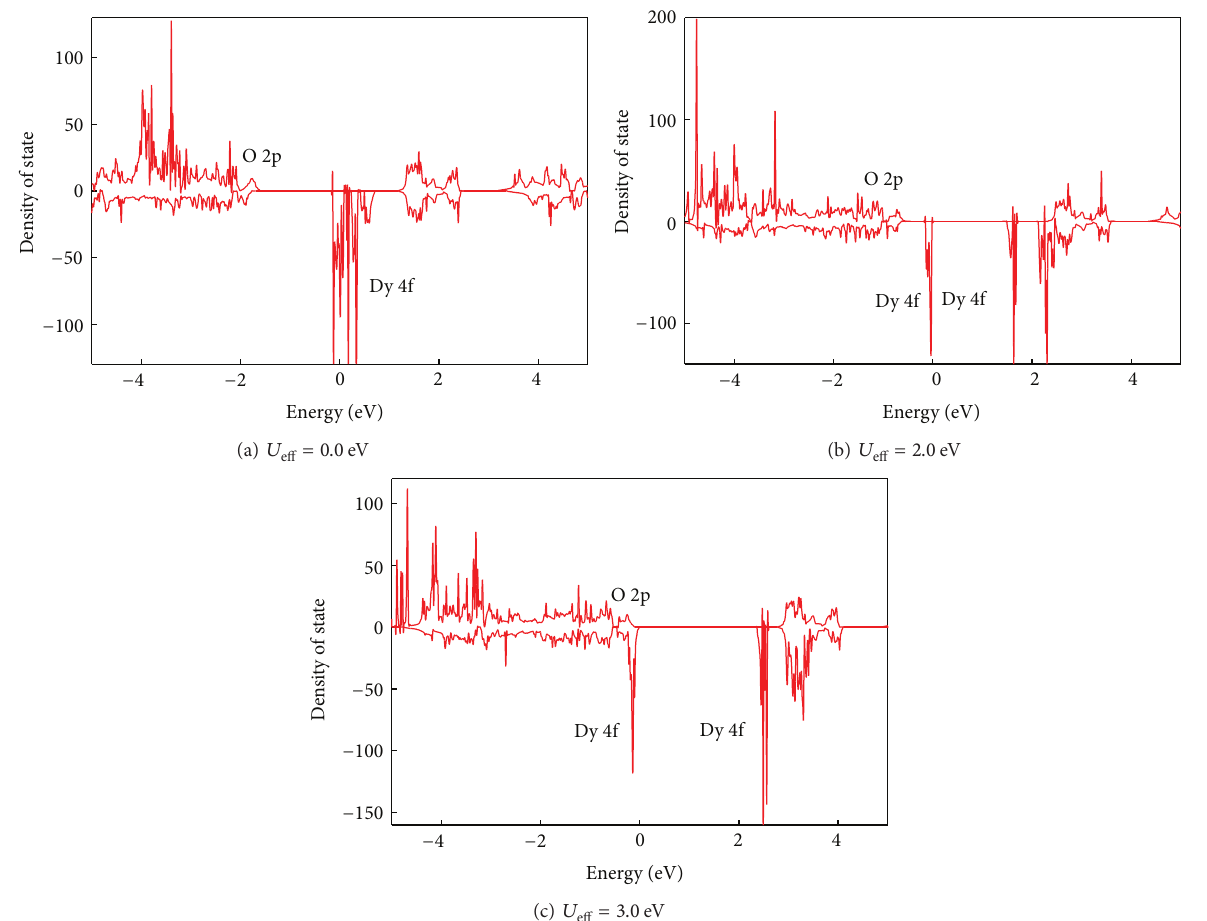
= 0.0 eV; (b) 𝑈 = 2.0 eV; and (c) 𝑈 = 3.0 eV. The upper and lower panels show the eff eff eff